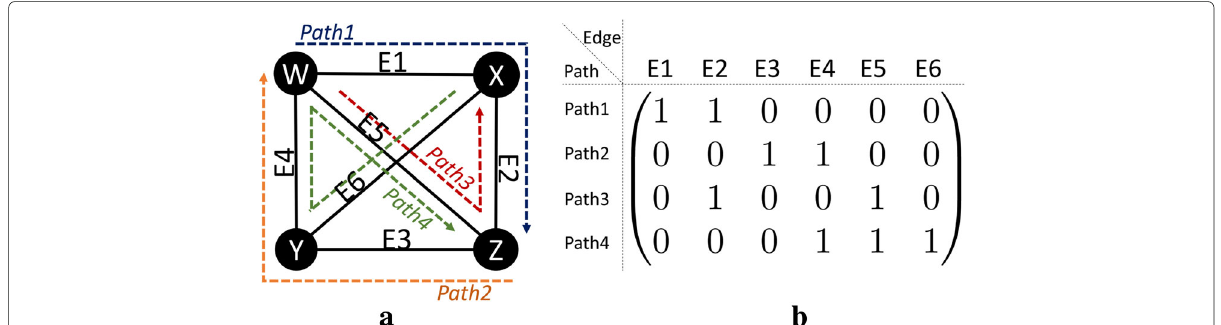
Fig. 7 a A simple example of a network tomography graph. W , X , Y , and Z are nodes in the network, and Path1,2,3 , and 4 are the probing paths through which the packets are sent. b The sensing matrix corresponding to the graph shown in a . The rows and columns of the matrix represent probing paths and edges